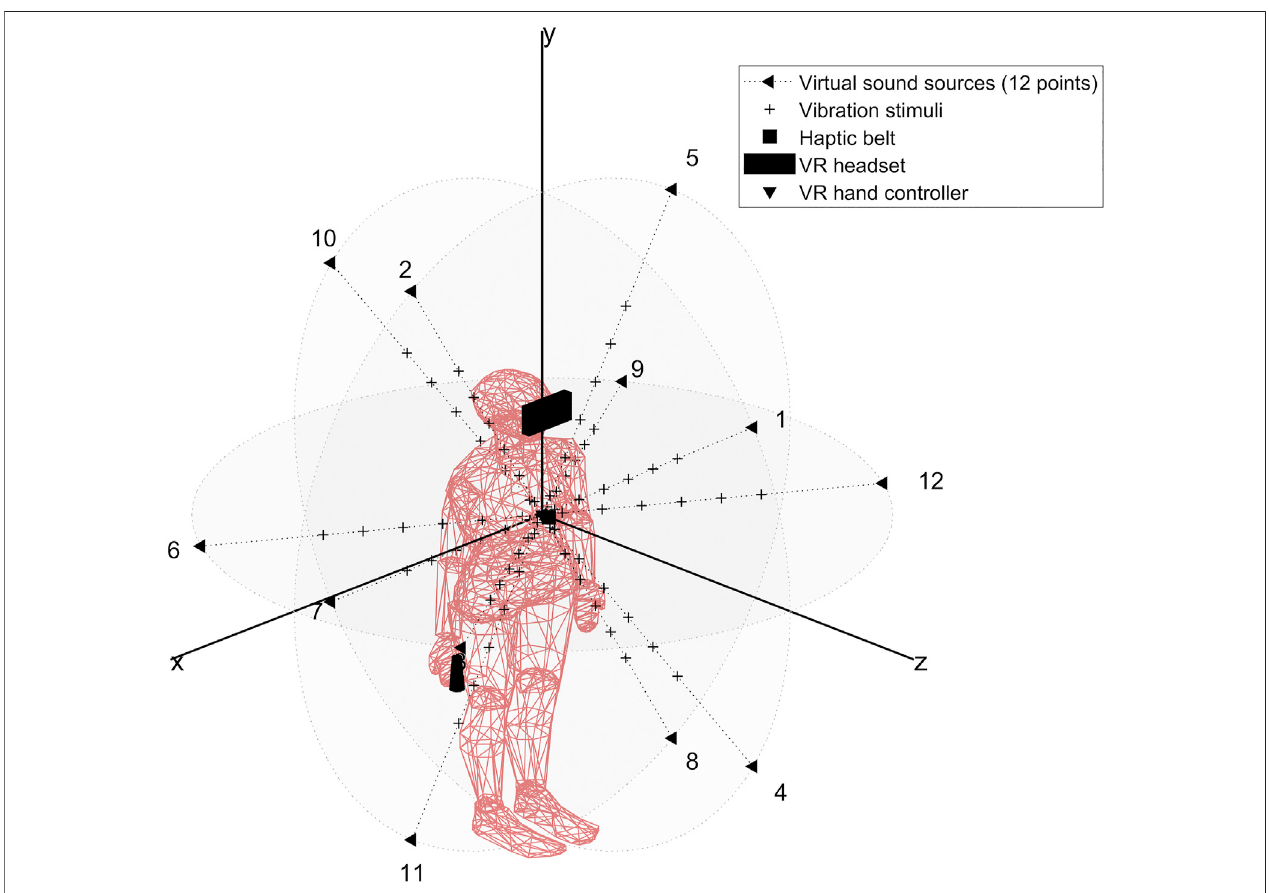
FIGURE 1 | VR setup, apparatus, and stimuli locations.